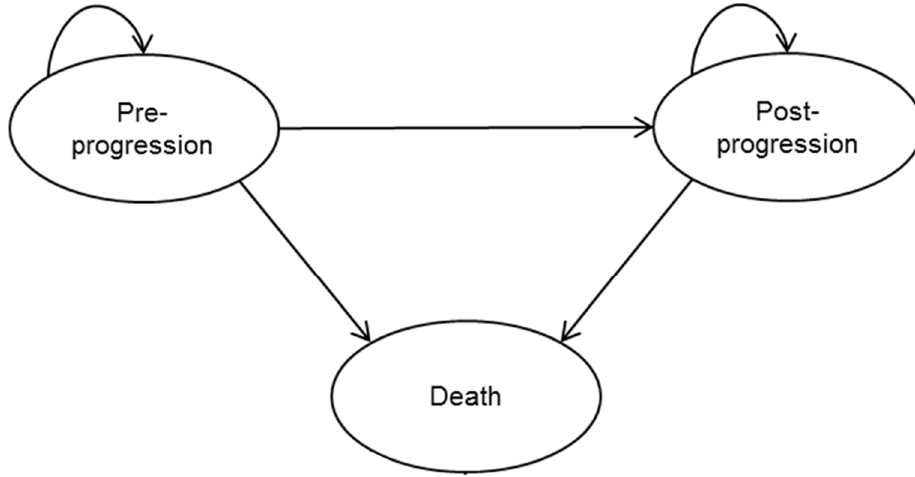
Figure 1. Model structure. Table 1. Summary of modeling